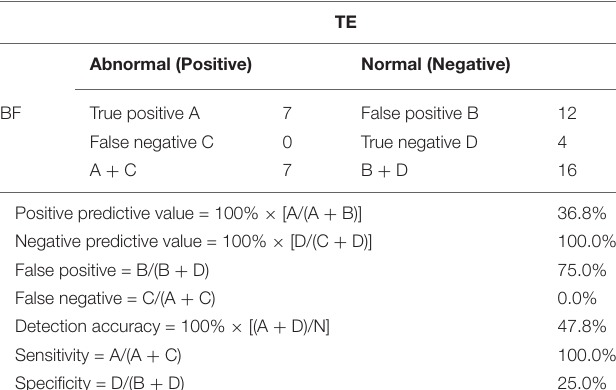
sample can obtain a data volume of 1.5 m reads.